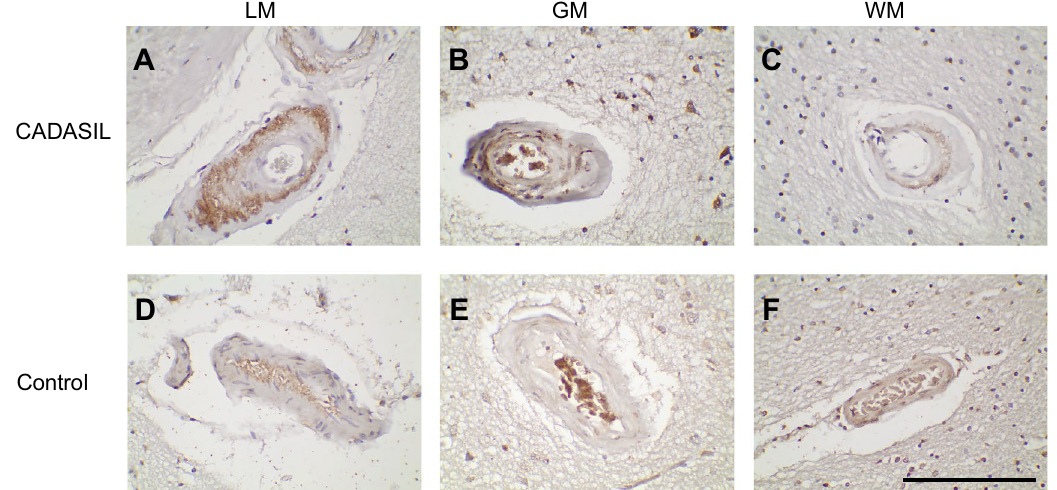
Figure 3. Localization of a second Asp-Pro cleavage site in NOTCH3 to cerebral arterial media in CADASIL. Immunohistochemistry using monoclonal antibody 145H at 0.6 µg/ml against the neo-epitope ending in Asp121 was performed on paraffin sections from CADASIL ( A – C ) and control ( D – F ) brain. Images of leptomeningeal (LM), gray matter (GM), and white matter (WM) arteries are shown. Additional CADASIL and control samples that were examined are shown in Supplementary Figs. 3 and 4. The scale bar that applies to all images marks 100 Fig. 2). Total collagen, defined by binding to the B-CHP peptide probe 21 , was present in the entire artery, includ- ing the adventitia, media, and intima, showing that cleavage at Asp121 occurred only part of the area where collagen accumulated (Fig. 4A,B,I,J, and Supplementary Fig. 5). Characterization of cleavage at Asp121 of NOTCH3.